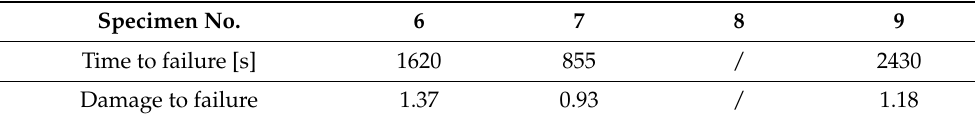
Table 11. Cumulative damage computed by Miner’s rule for the Diamond specimens. Specimen